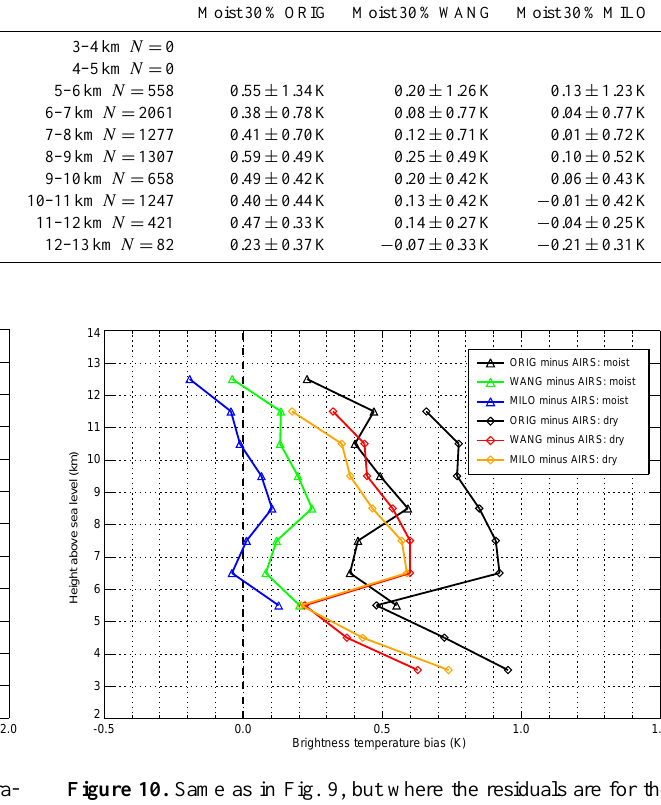
Figure 10. Same as in Fig. 9, but where the residuals are for the moistest 30% and driest 30% of the water vapor profiles. The me- dian values shown in this plot, along with the standard deviations, are given in greater detail in Table